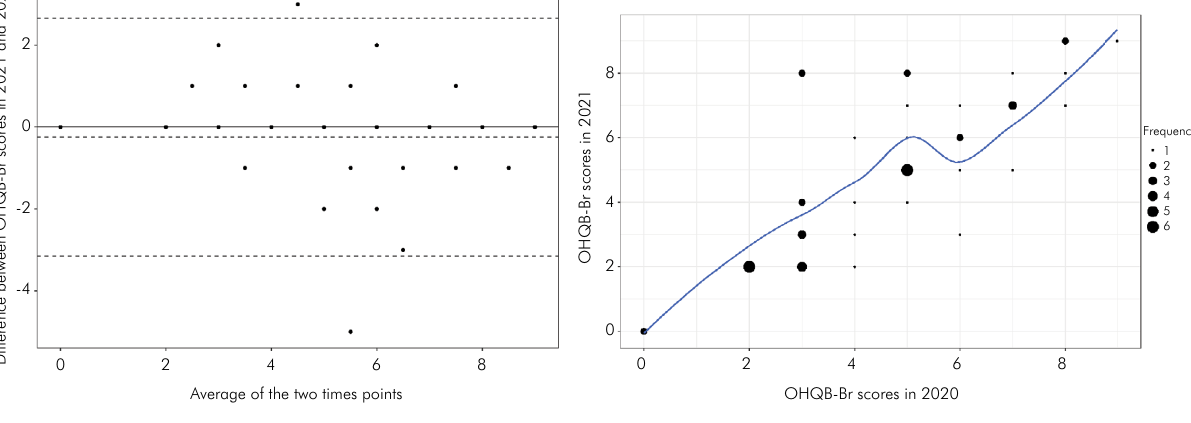
Figure 2. Bland Altman plot (left) and dispersion graph (right) in relation to the OHBQB-Br from 2020 and 2021.